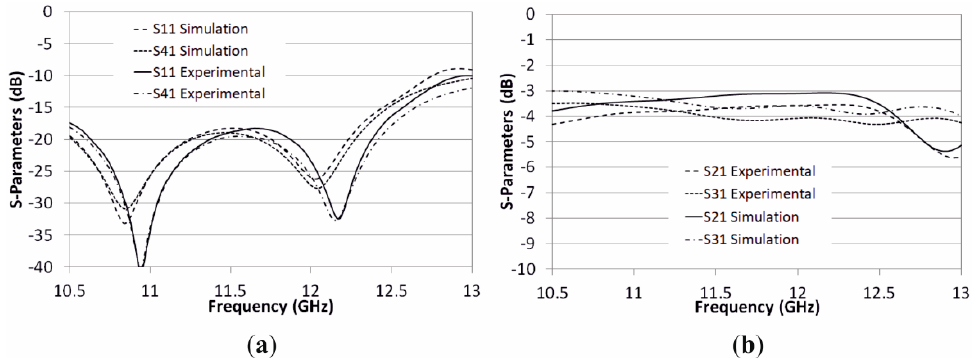
Figure 5. Comparison between simulated and experimental responses of the coupler in Figure 4. ( a ) Reflection coefficient and isolation; ( b ) Transmission coefficients. Figures adapted from